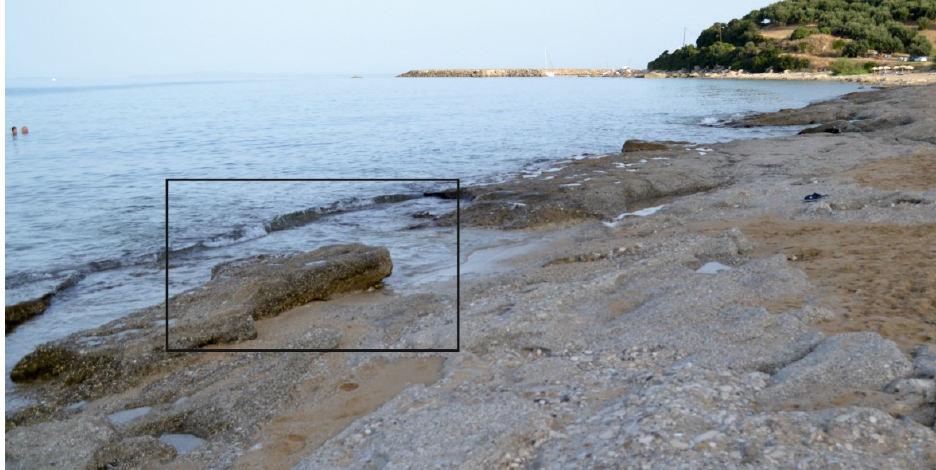
Figure 4. The middle study area in Lygias showing moderately seaward inclined alluvial fan con- glomerates and slightly inclined beachrocks. Rectangle indicates the close up view of the beachrocks shown in the Figure 5.